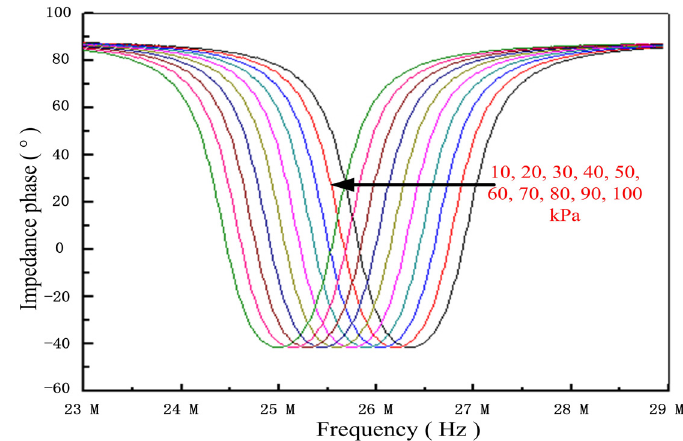
Figure 9. Impedance phase curves versus pressure.